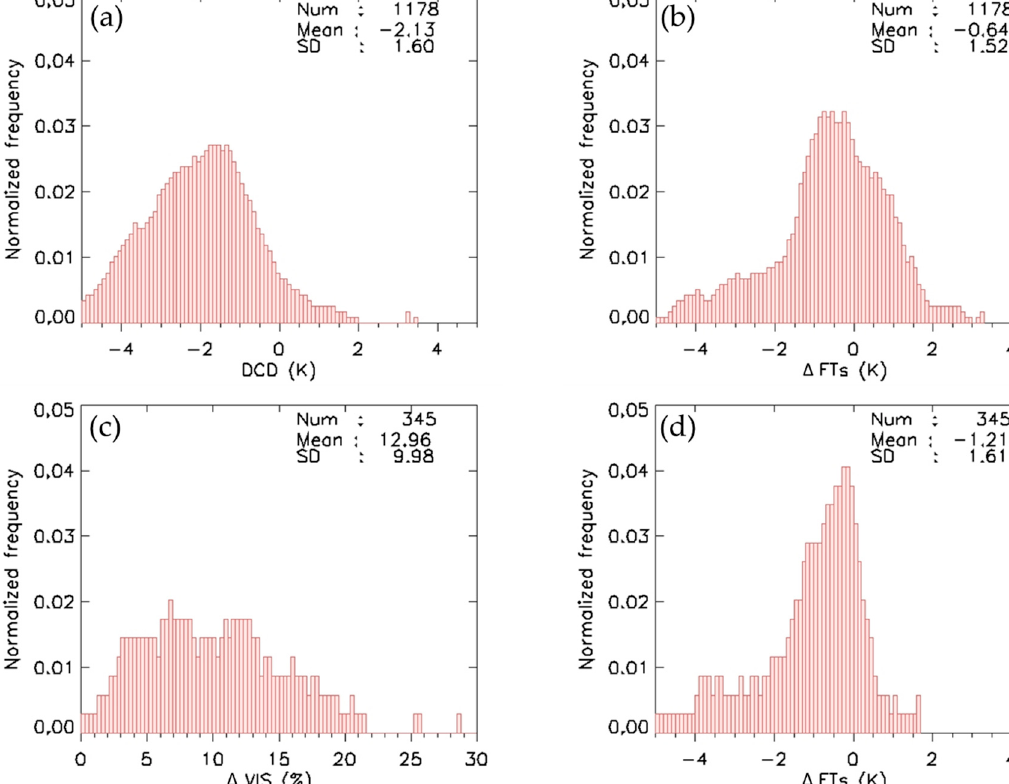
Figure 6. Frequency distribution of the optical/textural properties of fog pixels in the training cases at nighttime ( a , b ) and daytime ( c , d ) on the coast. ( a ) DCD, ( b , d ) Δ FTs, and ( c ) Δ VIS.